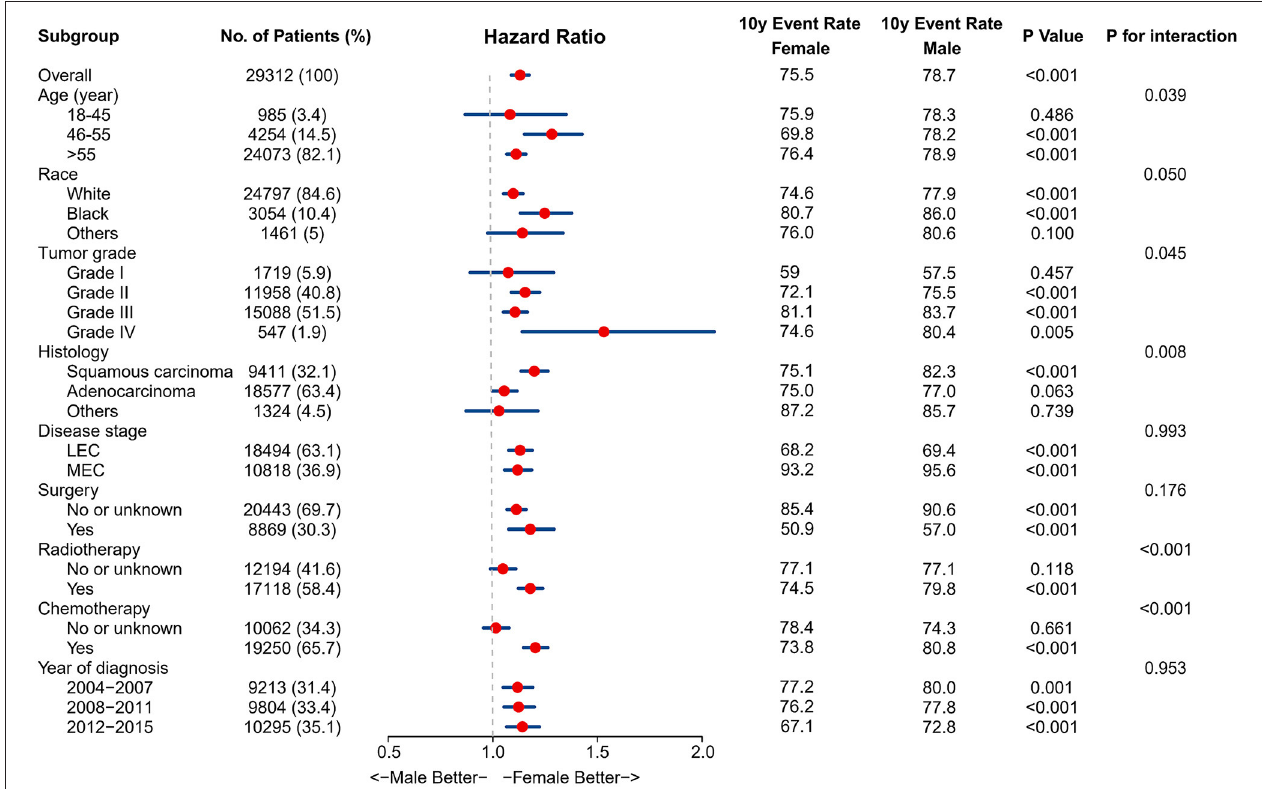
FIGURE 3 | Results for the subgroup analyses and interaction tests of sex-based effects on cancer-specific survival are summarized in a Forest plot.